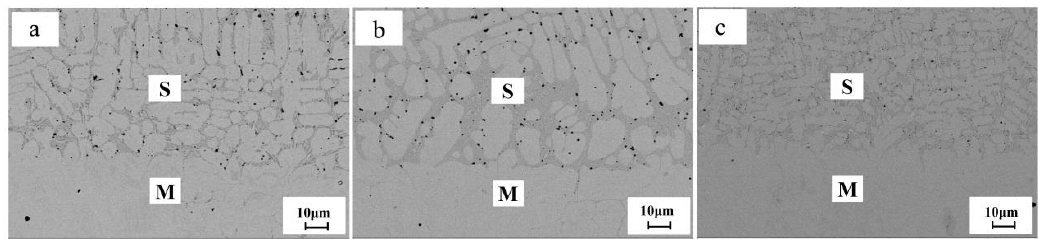
Figure 6. Morphology of carbide in the different surfacing layers. ( a ) 5Cr13; ( b ) 8Cr13; ( c ) 8Cr13MoV. Notes: S(surfacing): M(matrix).